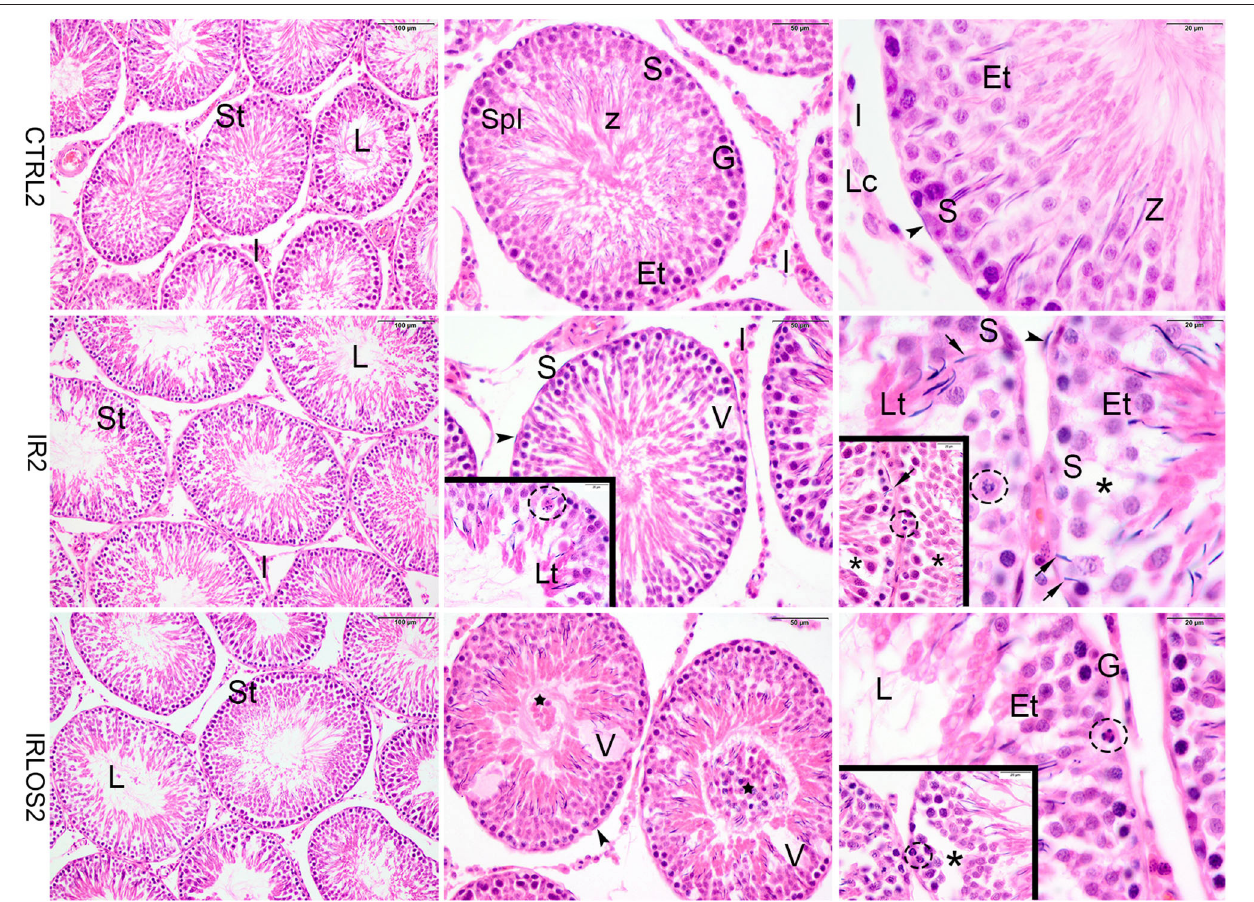
FIGURE 1 | Representative photomicrographs of the testis from control (CTRL 2), irradiated (IR 2), and irradiated and treated with losartan (IRLOS 2) groups 2 days after the exposure, stained with hematoxylin and eosin. In the control group, the testis exhibited a classic architecture and normal seminiferous tubules (St) lined by Sertoli cells (S), which supported germ cells in different stages of differentiation. Pattern interstitial tissue (I) with Leydig cells (Lc) aggregates was also observed. In the irradiated groups, independently of the treatment, seminiferous tubules exhibited damage signal irradiation, characterized by loss of germ cells (*), presence of vacuoles (V), germ cells with pycnotic nucleus (dashed circle), suggesting apoptotic death and sloughing of cells into the lumen ( ⋆ ). Note retention and phagocytose of step-19 spermatids in Sertoli basal cytoplasm ( → ). Et, early spermatids; G, spermatogonia; Lt, late spermatids; L, lumen; SpI, primary spermatocytes; Z, sperm. ◮ = peritubular myoid cells. Scale bar, first column (100 µ m), second column (50 µ m), and third column and insets (20 µ m).